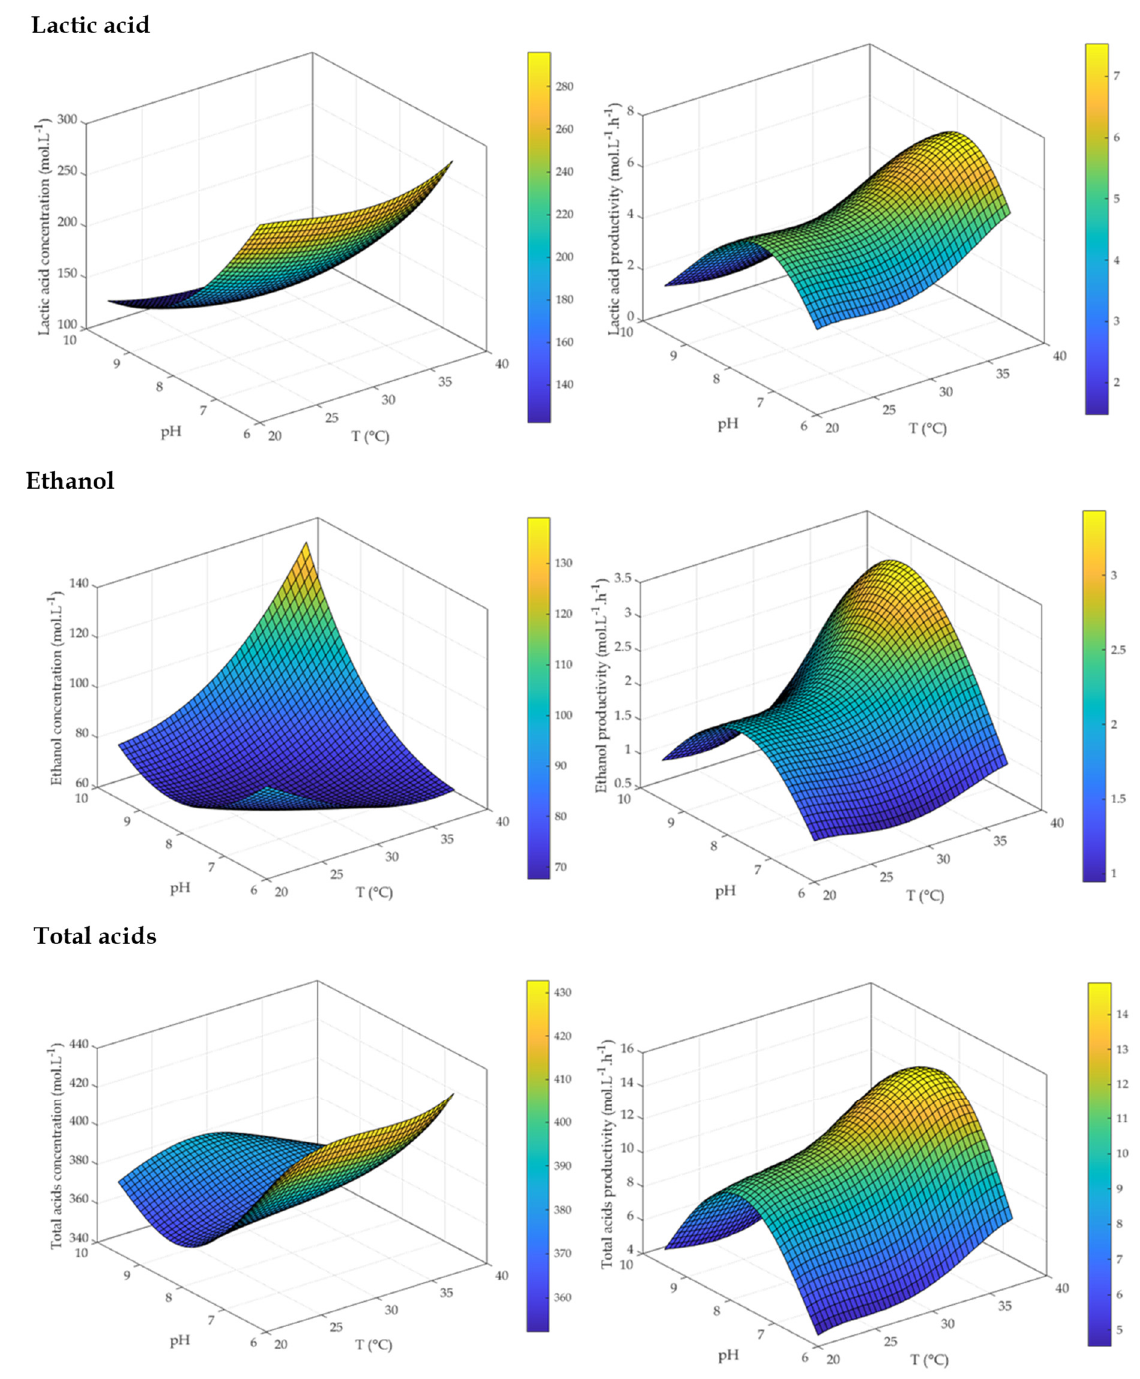
Figure A3. Evolution of final concentrations (left) and batch-average productivities (right) with temperature and pH for lactic acid, ethanol, and total acids.